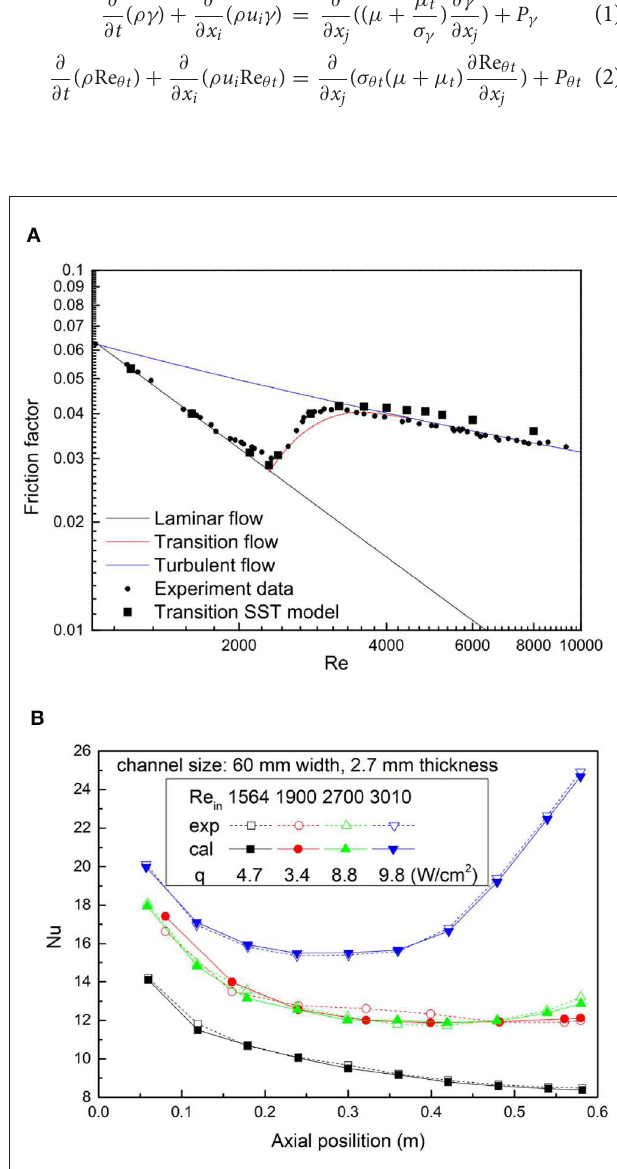
FIGURE 1 | Model validation. (A) Validation of the friction factor. (B) Validation of the heat transfer